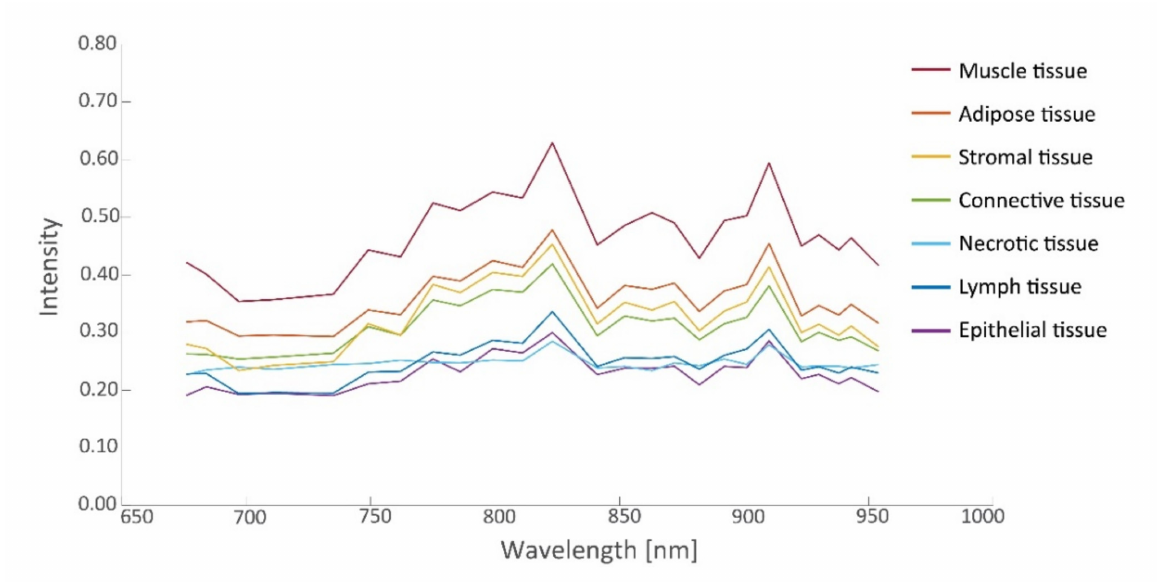
Figure 5. Intensity values (median) as a function of wavelength for various non-tumorous